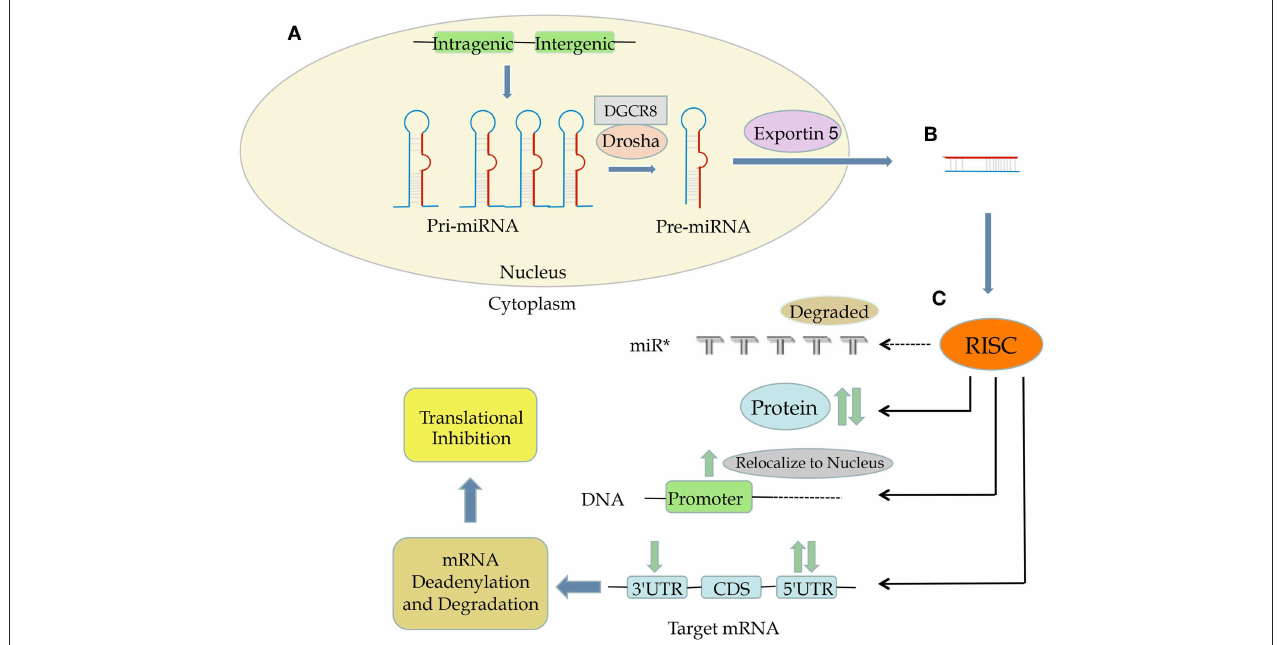
FIGURE 1 | The process and functions of miRNA. (A) Both intergenic and intragenic genes encode miRNAs. (B) Mature miRNAs are transcribed from pri-miRNA and then then pre-miRNA, translocated from nucleus to cytoplasm by exportin 5, and composed of RNA-induced silencing complex (RISC). (C) RISC can target mRNA at ′ ′ 3 UTR, CDS, and 5 UTR as well as DNA promoter sequences and even proteins, leading to upregulation or downregulation of a specific